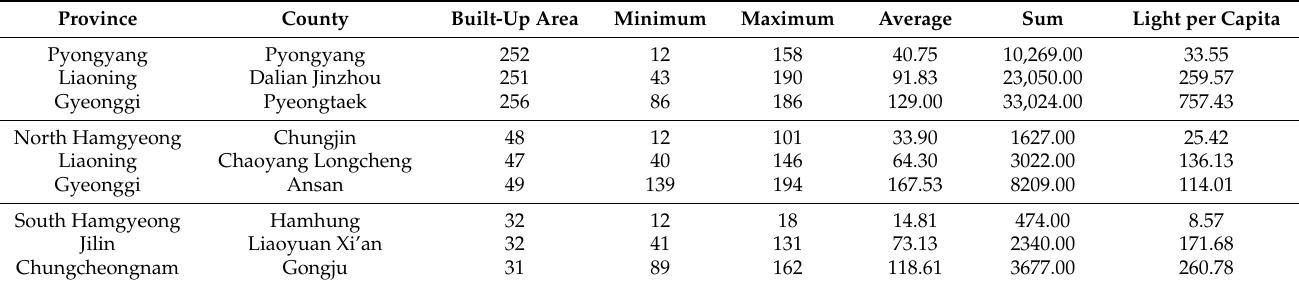
Figure 7. Comparison of urban built-up area between DPRK and China’s Jilin and Liaoning. Table 4. Comparison of typical cities in DPRK, China, and ROK [km 2